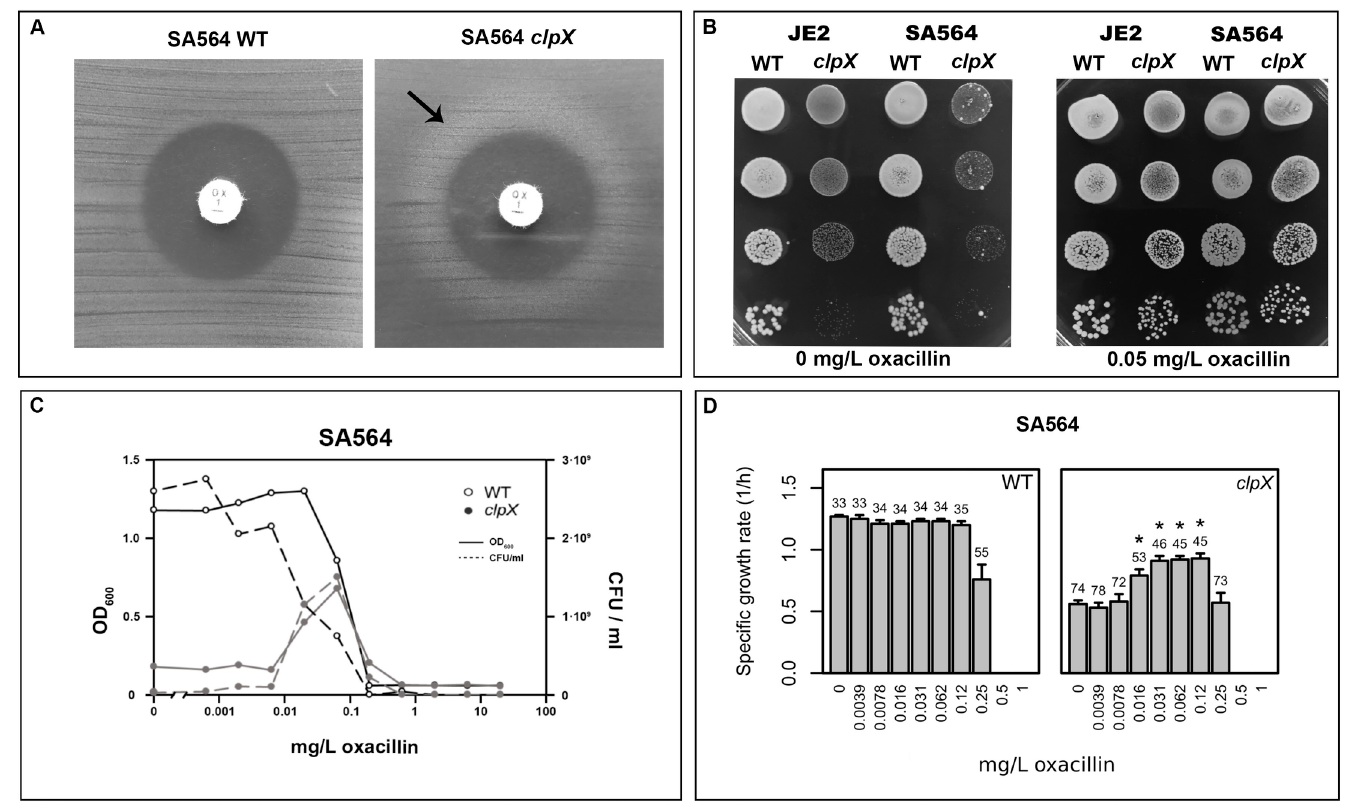
Fig 1. Growth of S . aureus clpX mutants is stimulated by β -lactams. ( A ) SA564 wild-type and SA564 clpX were plated at 37˚C and tested for susceptibility to oxacillin in a disc diffusion assay; arrow points to zone of improved growth. Disks contain 1 μ g oxacillin. ( B ) The S . aureus wild-type strains, SA564 (MSSA) and JE2 (MRSA) and the corresponding clpX deletion mutants were grown exponentially in TSB at 37˚C. At OD 600 = 0.5, the cultures were diluted 10 1 , 10 2 , 10 3 and 10 4 -fold, and 10 μ l of each dilution was spotted on TSA plates +/- oxacillin and the plates were subsequently incubated at 30˚C for 24 h. Note that fast growing suppressor colonies appear with high frequency when the SA564 clpX cells are plated at 30˚C as described in [20]. ( C ) Final yield (OD 600 or cfu ml -1 ) reached by SA564 wild type and SA564 clpX cells when grown in microtiter plates for 24 h at 30˚C in the absence or presence of increasing concentrations of oxacillin as indicated. ( D ) Growth rates (h -1 ) for S . aureus SA564 wild-type and SA564 clpX when grown at 30˚C in the absence or presence of increasing concentrations of oxacillin were determined in a Bioscreen C instrument. The average growth rate (h -1 ) and standard deviations from three biological replicates were plotted. Numbers above bars indicate average doubling time in minutes. Asterisks indicate significantly improved growth rate (P < 0.05). The P values were obtained by comparing the growth rates at each concentration to the growth rate without antibiotics and were calculated using Student’s